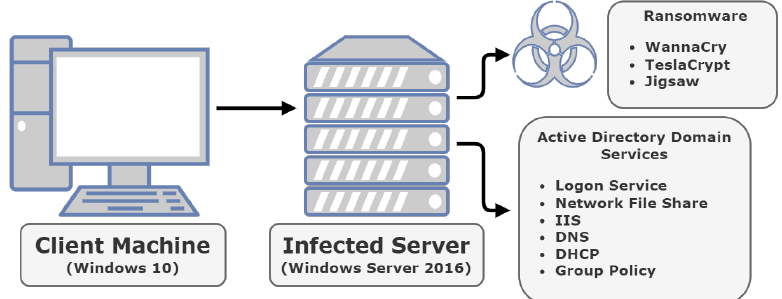
Figure 1. Overview of the investigation